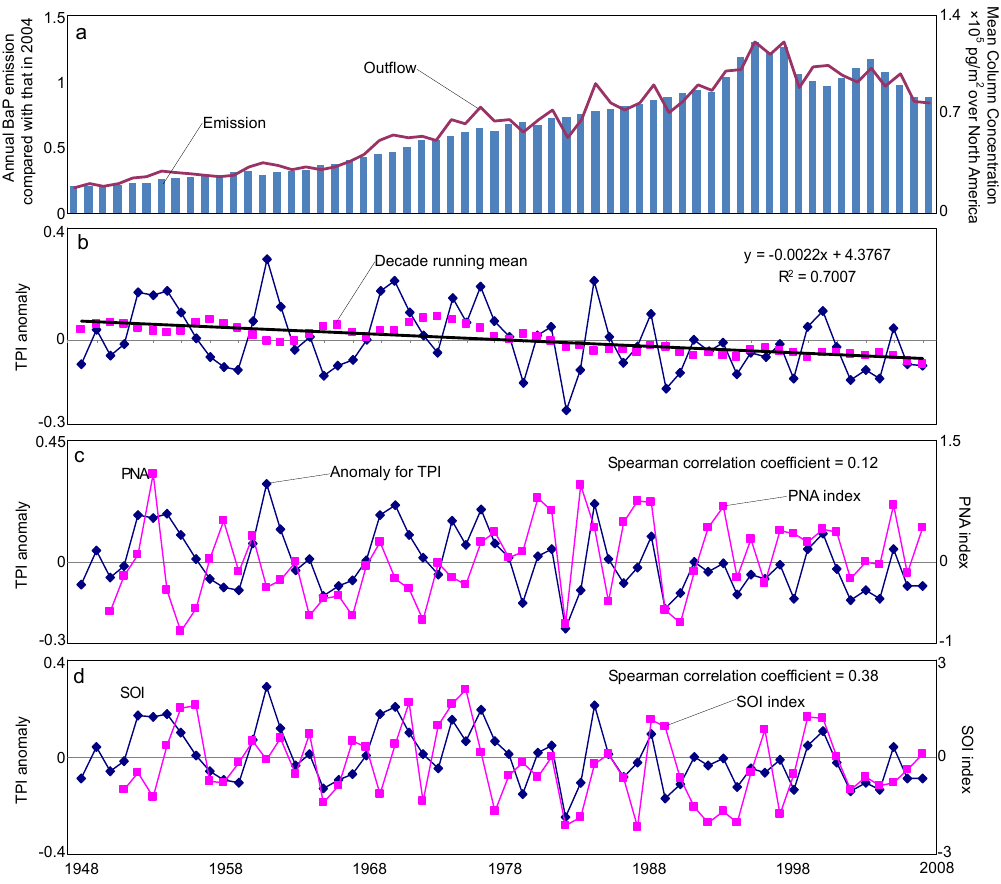
Figure 7. Interannual variability of transpacific transport of BaP during 1948 ‐ 2007. a) interannual variation of BaP emission over East Asia and mean BaP column concentration over the region of North America within the boundaries of 30 ‐ 70°N, 75 ‐ 125°W, and 0 ‐ 7 km altitude; b) interannual variation of transpacific transport index (TPI) anomaly, and its decadal running mean; c) the relationship between TPI anomaly and the anomaly of the Pacific North America Index (PNA); d) the relationship between TPI anomaly and the anomaly of the Southern Oscillation Index (SOI).